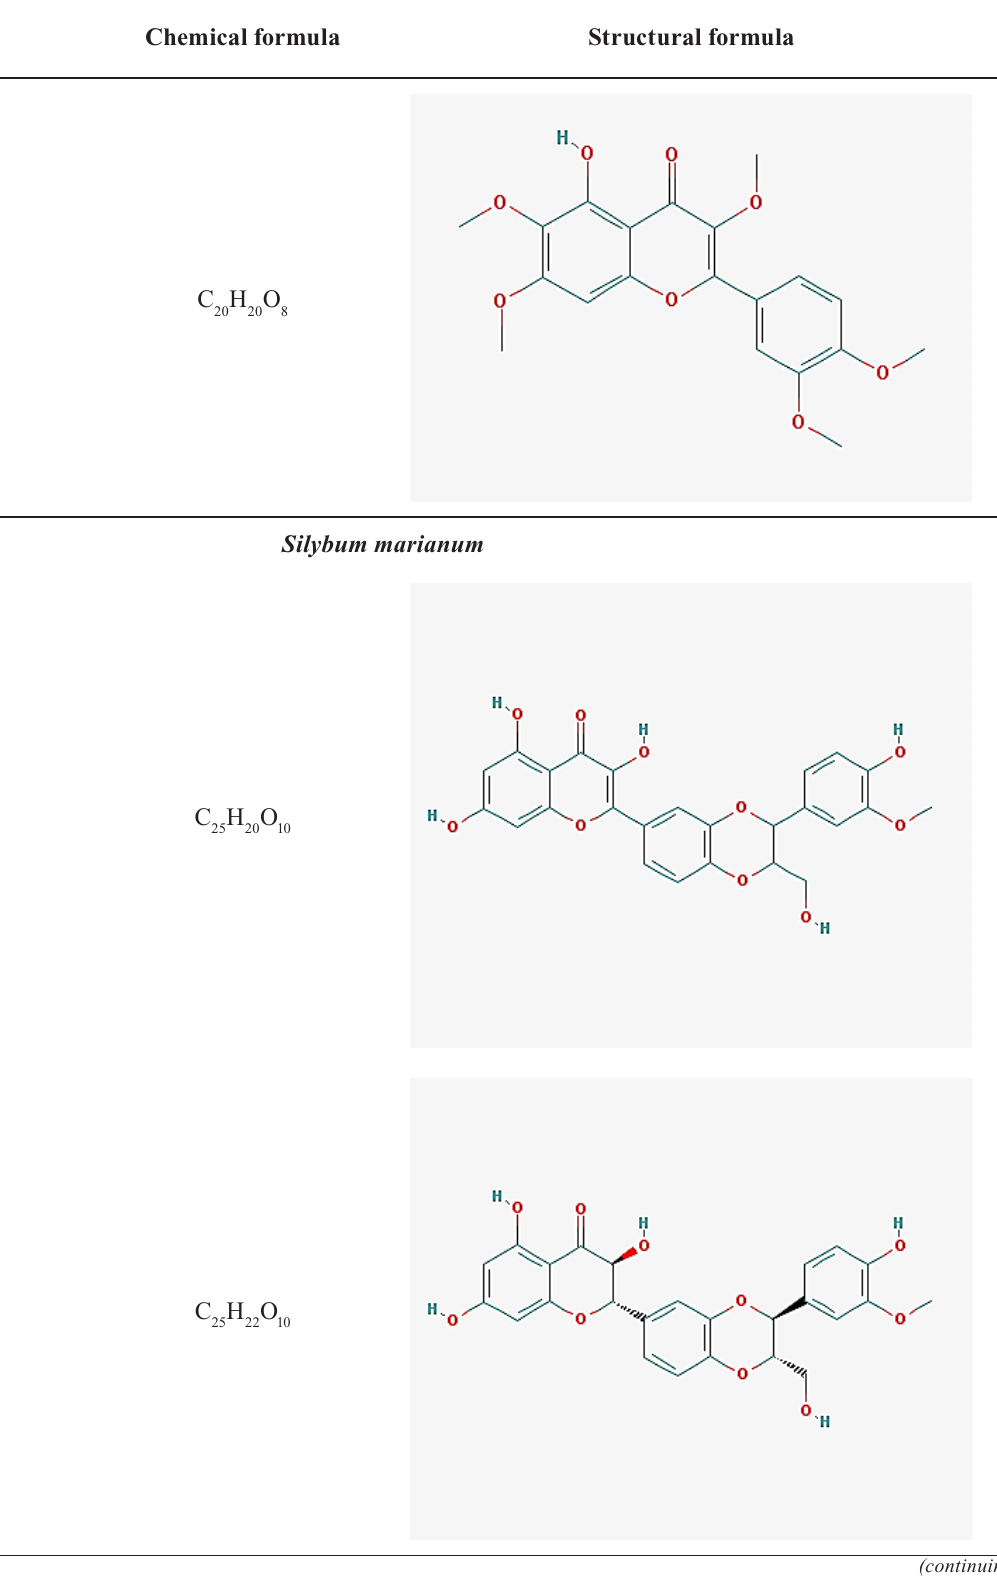
TABLE I - P hytochemicals from Tanacetum parthenium and Silybum